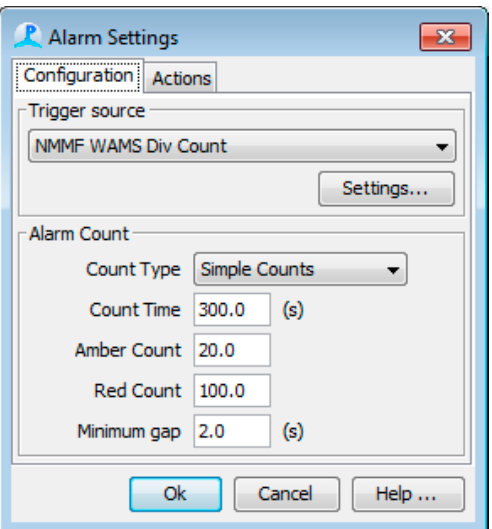
Figure 6. An example of the alarm module in PAMGuard. This module allows the user to identify whistle rates of interest and have the program trigger an email alert to be sent to the researcher when the detections surpass a user defined threshold. When the threshold is surpassed the program records an image of the current spectrogram and attaches it to the email for review by the recipient. The WAMS plugin provides the user with a number of options to better serve the specific application. The WAMS plugin is able to accept notifications from any of the detector modules (e.g., Click Detector, Whistle and Moan Detector) within PAMGuard.